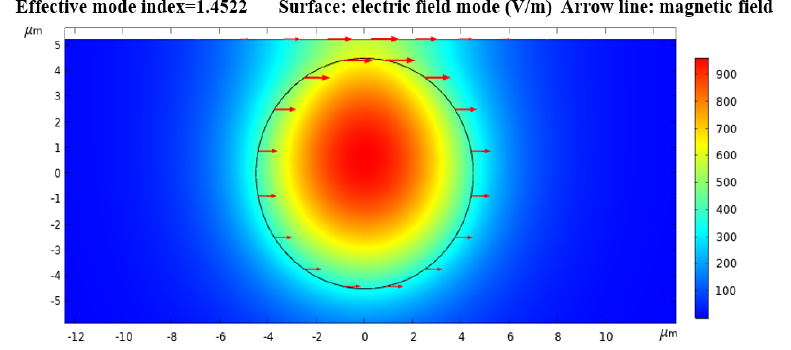
Figure 2. The electric and magnetic transmission field simulation in COMSOL.